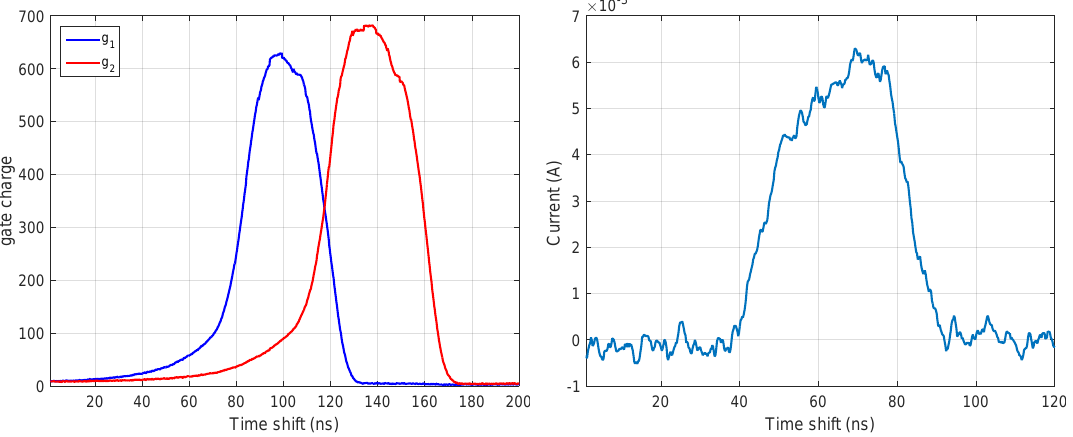
Figure 16. Sampled gate response using 4ns light pulse (left) and measured light pulse shape using fast diode (right).